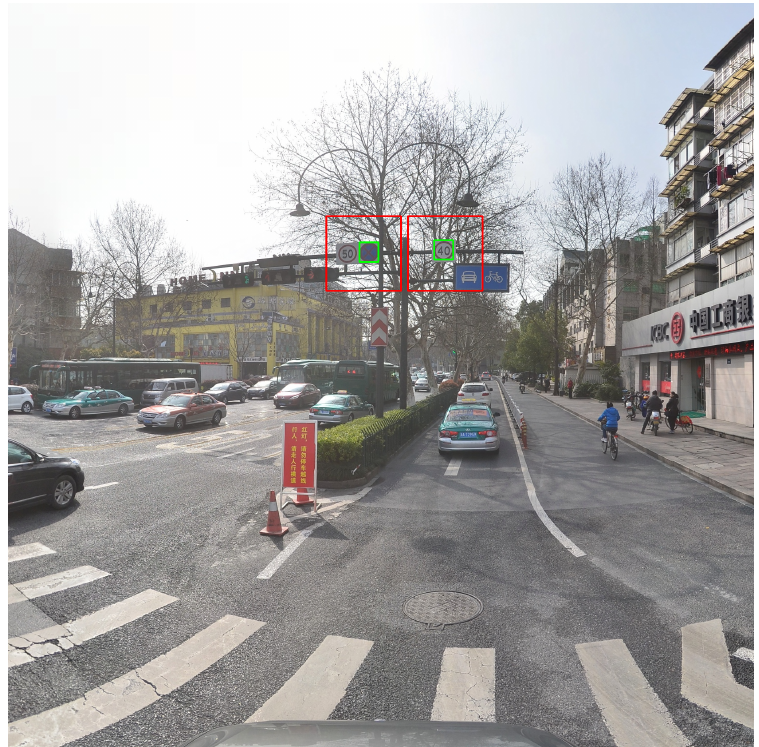
Figure 3. Improved matching with aligned matching strategy. The same color code is used as in Figure